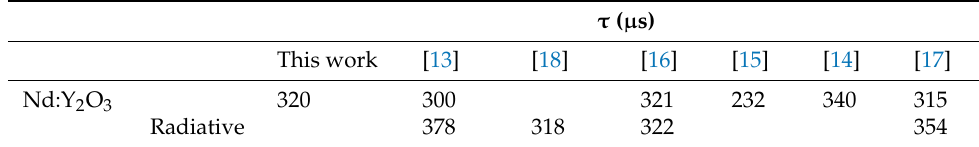
Table 7. Decay time of 1%Nd:Y 2 O 3